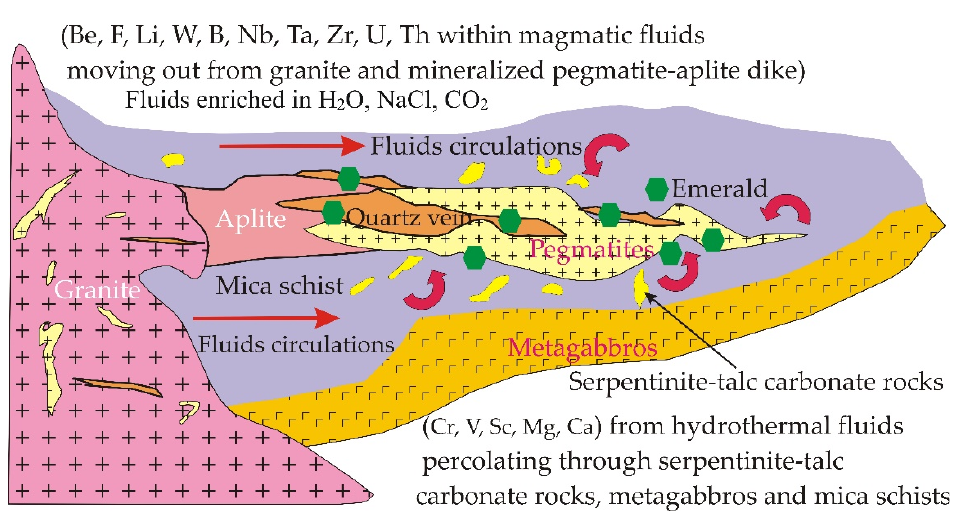
Figure 7. Genetic model (modified after Groat et al. [68] and Beal and Lentz [69]) for green beryl (emerald) along the mineralized contact between metasediments and pegmatites at Wadi Nugrus, South Eastern Desert of Egypt.